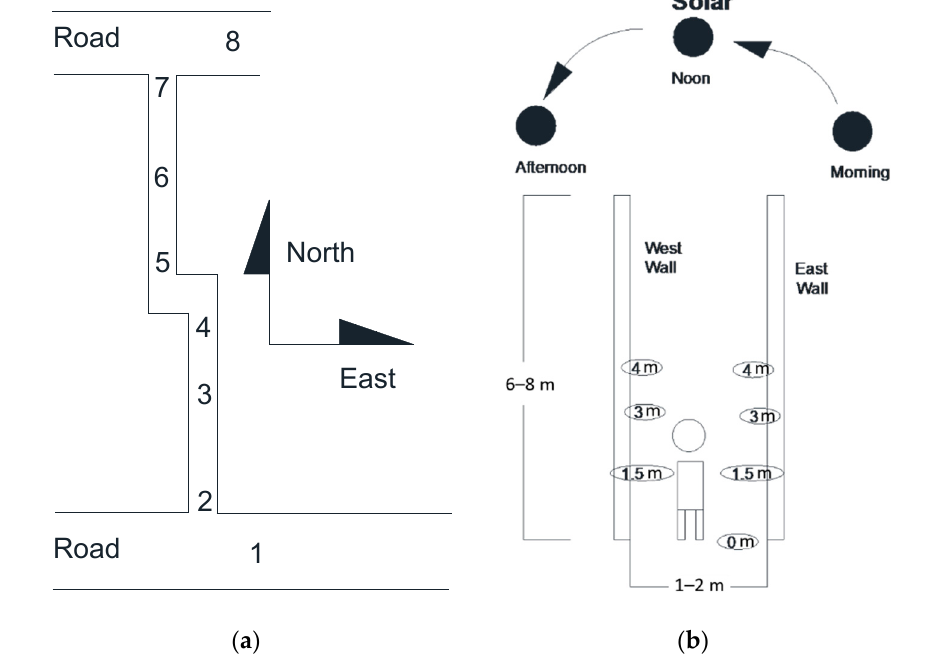
Figure 4. Measuring points: ( a ) top view; ( b ) front view. Table 1. Measurement time and weather conditions during investigation [17].